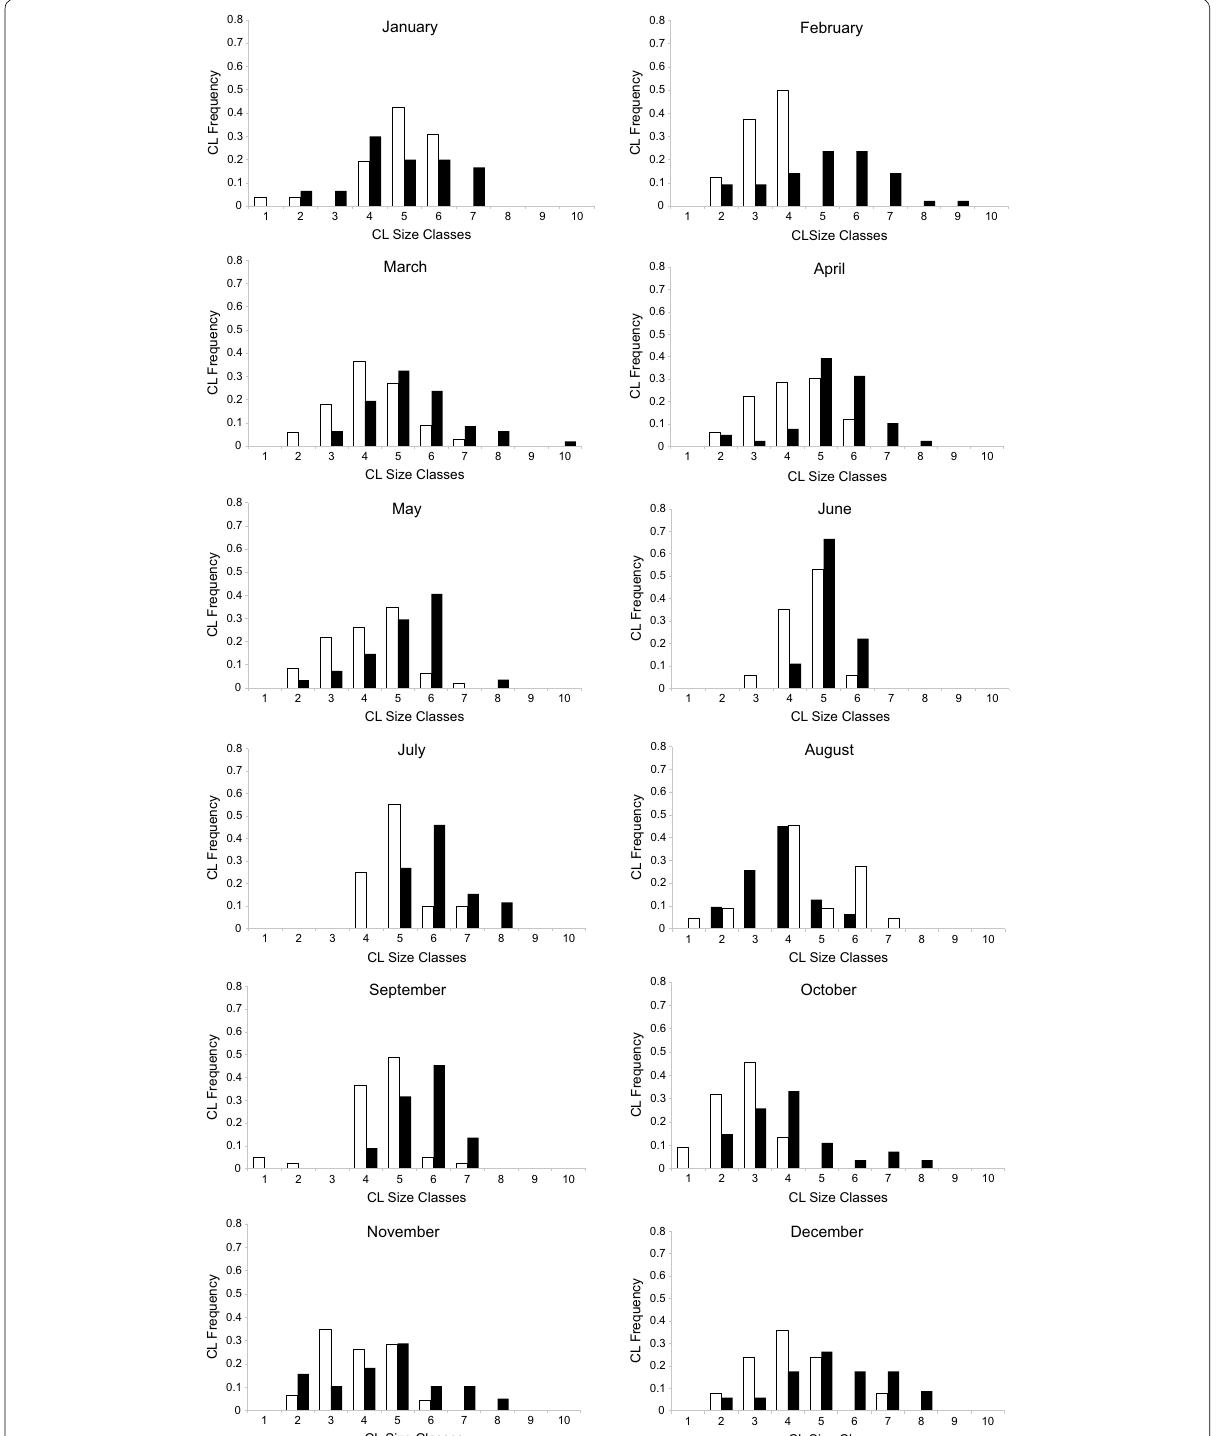
Fig. 2 Frequencies of Carapace Length (CL) distribution in each size class per month, separately for female (white bars) and male (black bars)